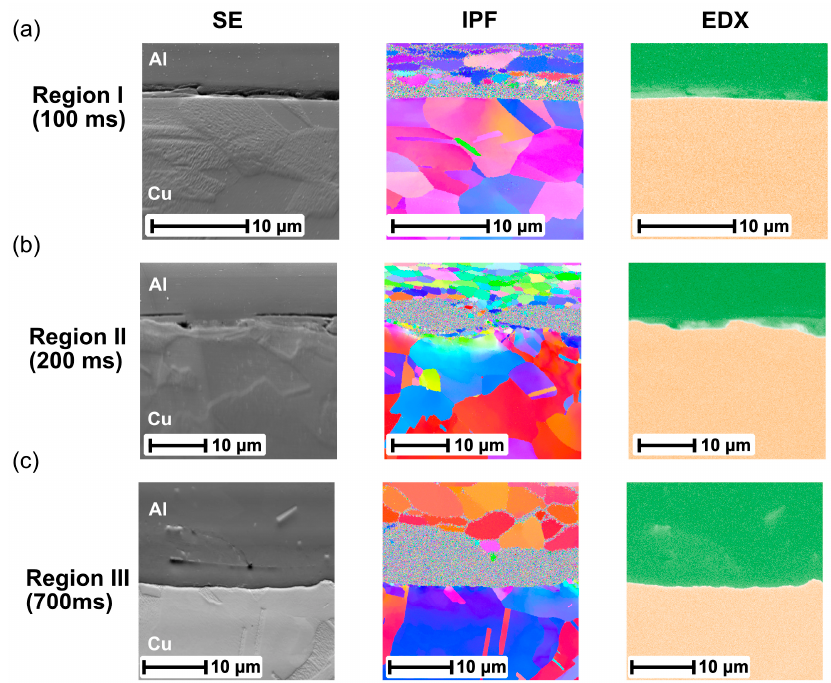
Figure 8. Magnified view of ( a ) region I at 100 ms, ( b ) region II at 200 ms, and ( c ) region III at 700 ms.